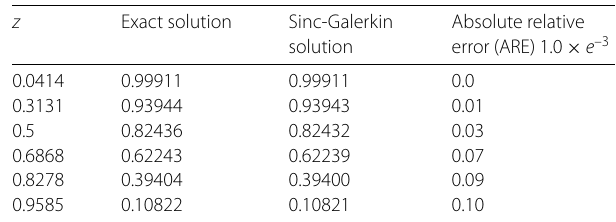
Table 4 The results of Problem 1 from [9]